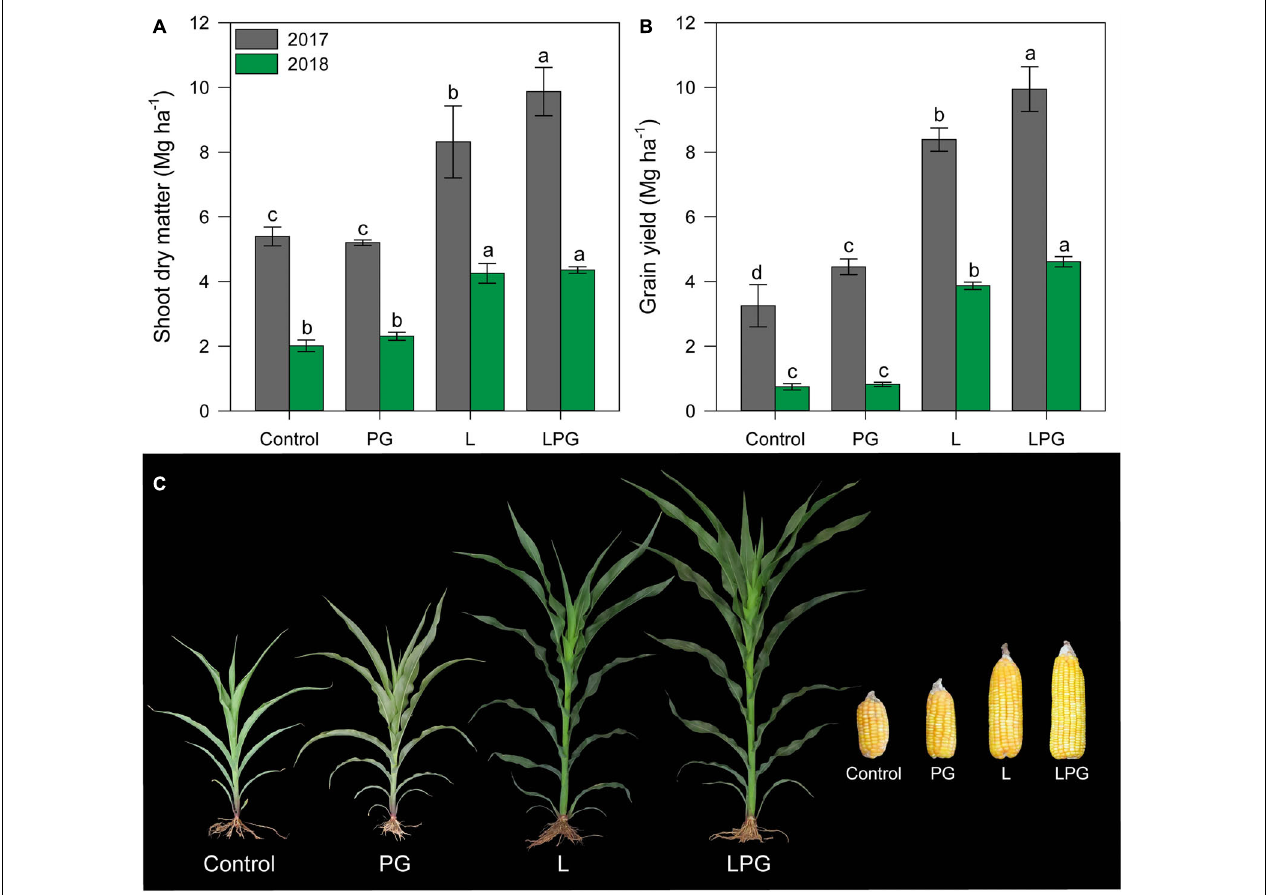
FIGURE 9 | Shoot dry matter (A) and grain yield (B) of maize as affected by surface-applied lime (L), phosphogypsum (PG), and lime + phosphogypsum (LPG) treatments. Different lower-case letters indicate significant differences between treatments for each growing season by Student’s t -test at p ≤ 0.05. Error bars express the standard error of the mean ( n = 4). Effect of soil amendments on maize development (2nd growing season = 2018) at 50 days after sowing and ear development at harvest (C) .